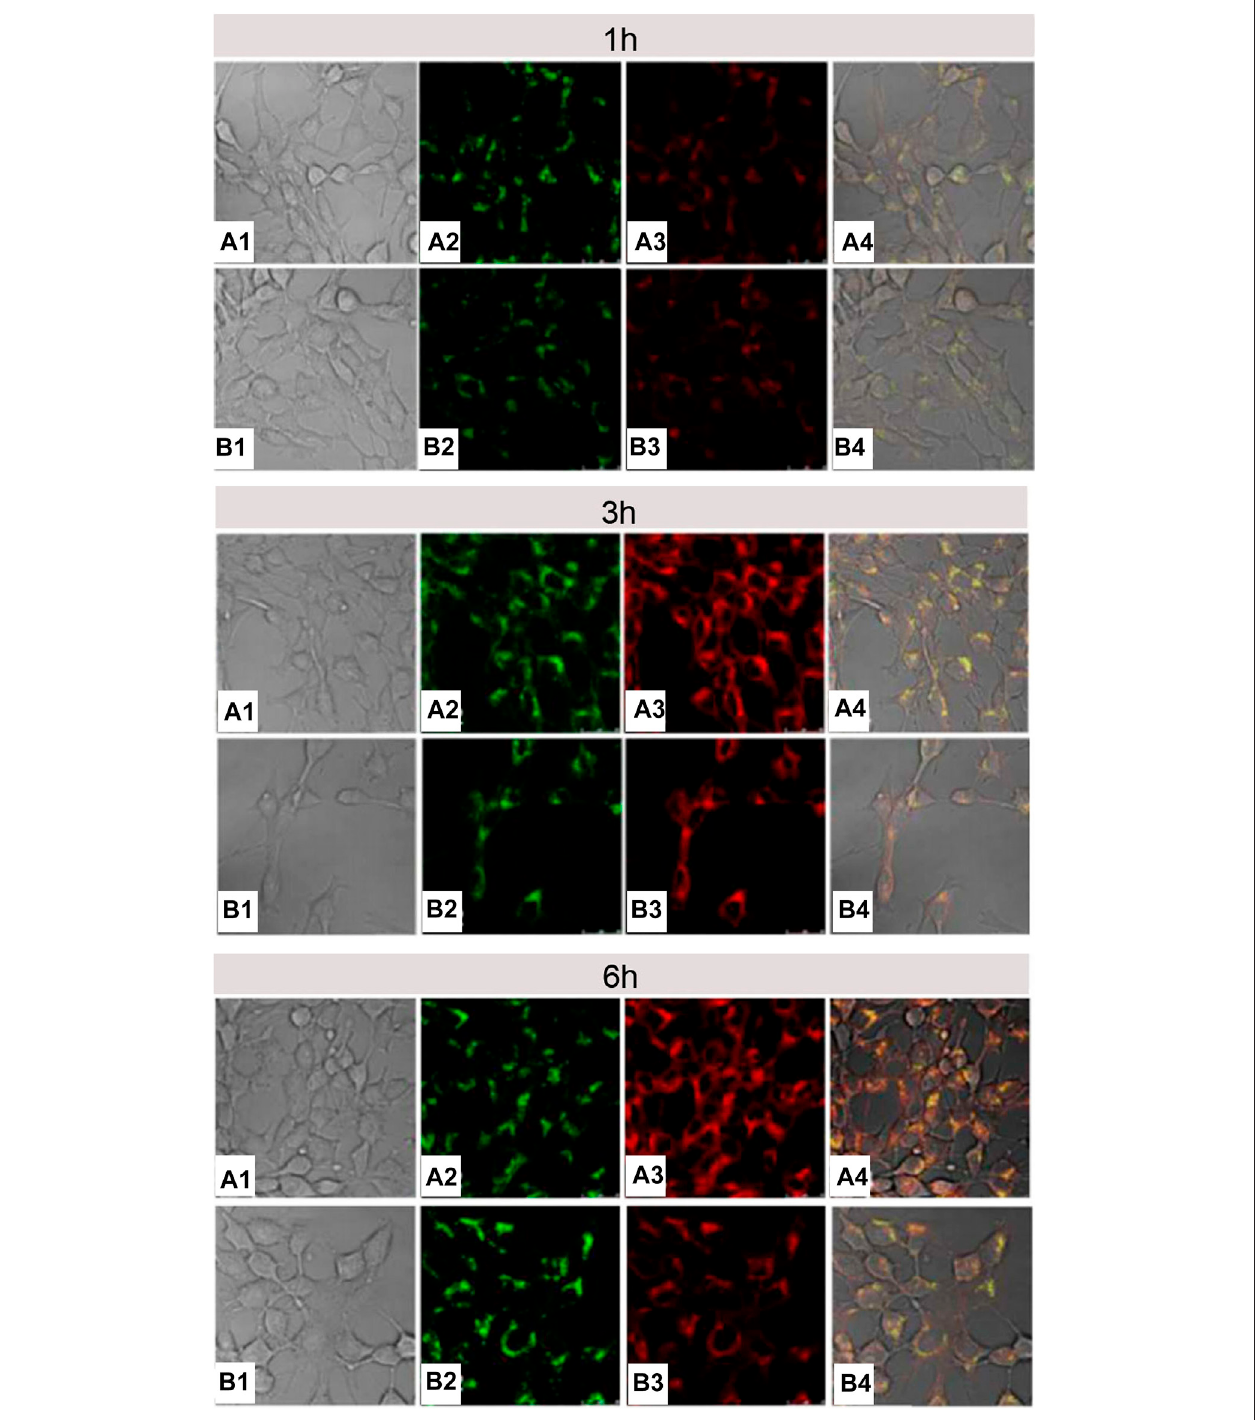
FIGURE14| TheCLSMimagesof4T1cellstreatedwithDOX/Arg-PEG-PCL-Py (A) and DOX/Ac-PEG-PCL-Pymicelles (B) for1,3,and6 h.Thenumbers 1,2,3, and 4 indicated the bright fi eld, LysoTracker Green fl uorescence, DOX fl uorescence, and the overlay images, respectively. The concentration of DOX was 10 μ g ml − 1 (Luo et al., 2016). Abbreviation: Arg-PEG-PCL, arginine-modi fi ed poly(ethylene glycol)-b-poly( ε -caprolactone); Ac-PEG-PCL, acetic acid-modi fi ed PEG-PCL; Py, pyrene.